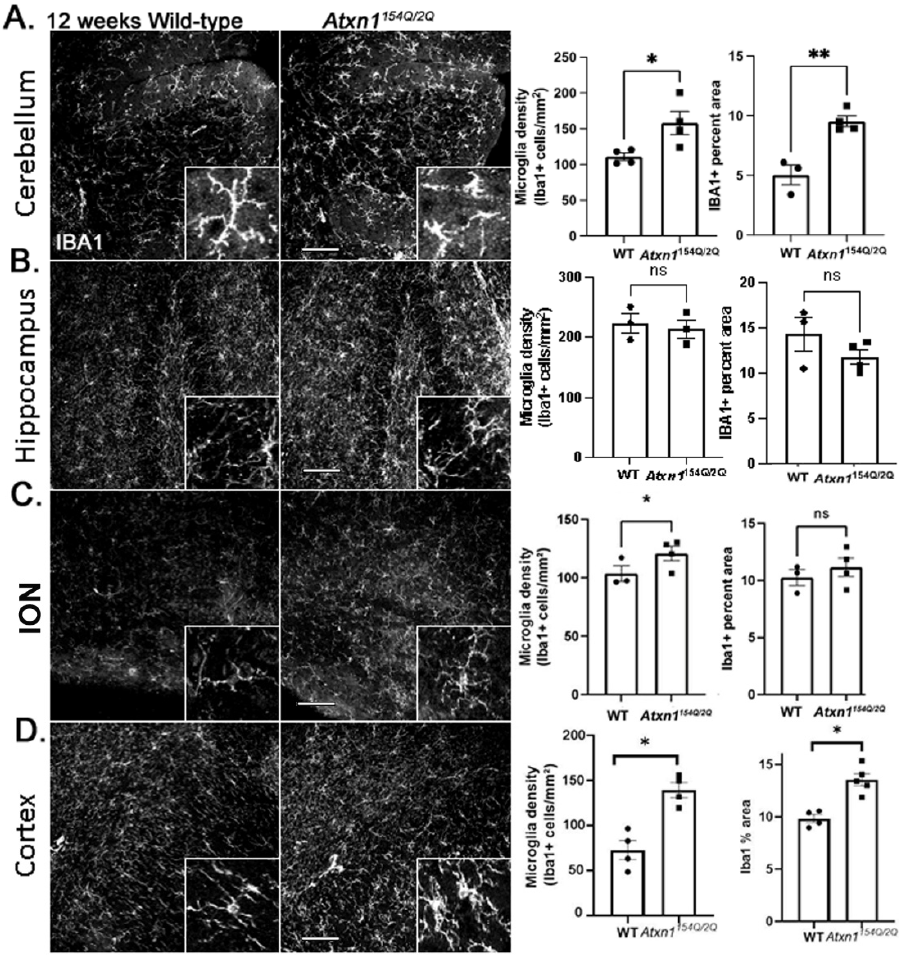
Figure 3. Early SCA1 microglial morphology in Atxn1 154Q/2Q mice. Brain sections from 12 weeks old Atxn1154Q/2Q and wild-type littermate controls (N = 3–5) were stained for Iba1. Confocal images of cerebellum (( A ), lobule X), hippocampus (( B ), dentate gyrus), brainstem (( C ), ION), and motor cortex (( D ), layer 6 and underlying corpus callosum) were used to quantify density of Iba1 positive microglia and Iba1 area. Images were acquired at 20 × (636.16 µ m × 636.16 µ m). Scale bars show 100 µ m. Insets in the lower right corners of each image show zoomed images (79.5 × µ m 79.5 µ m) for qualitative assessment of microglia morphology. Data are presented as mean ± SEM with average values for each mouse. N = 3–5 mice of each genotype (WT and Atxn1 154Q/2Q ) with individual mice represented by a dot in bar graphs. ns: not significant, * p < 0.05, ** p < 0.01. Student’s t